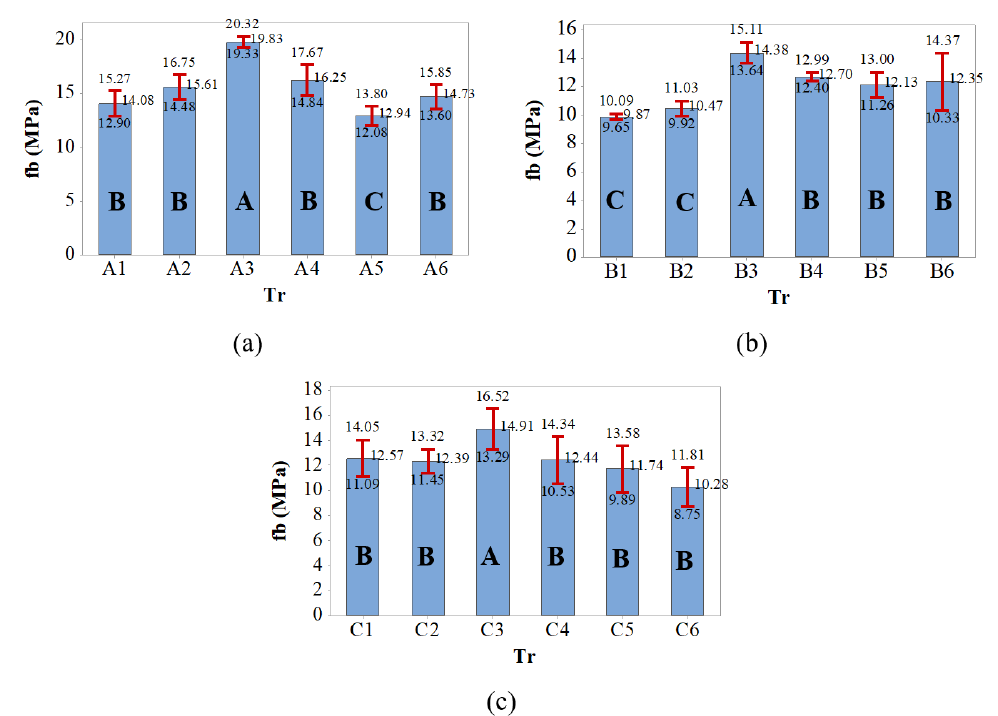
Figure 3. Results of compressive strength (f b - MPa) for the six experimental